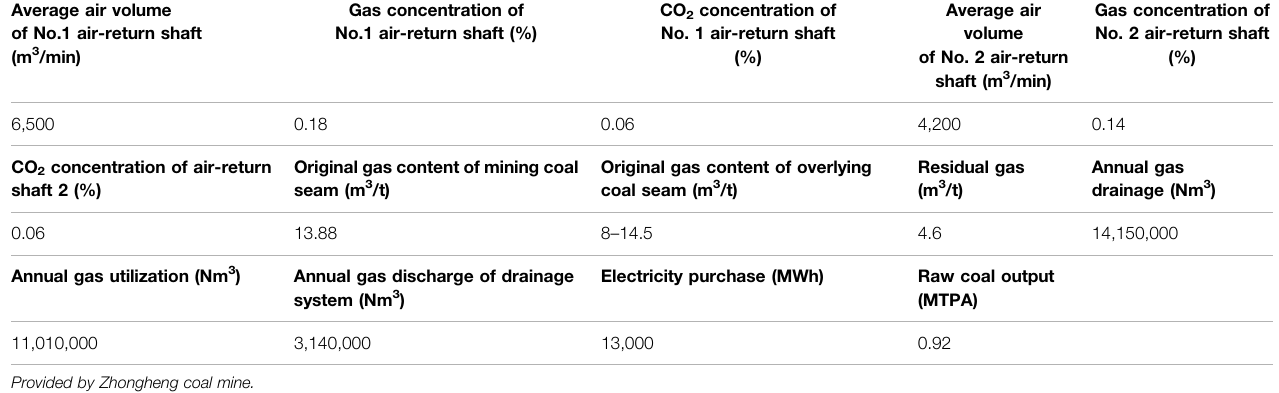
Gas concentration of No.1 air-return shaft (%)